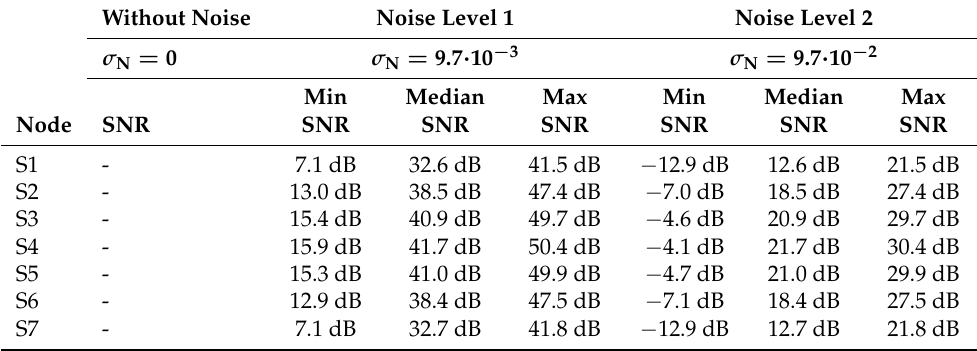
Table 2. Table with signal-to-noise ratio for displacement in the z direction for different